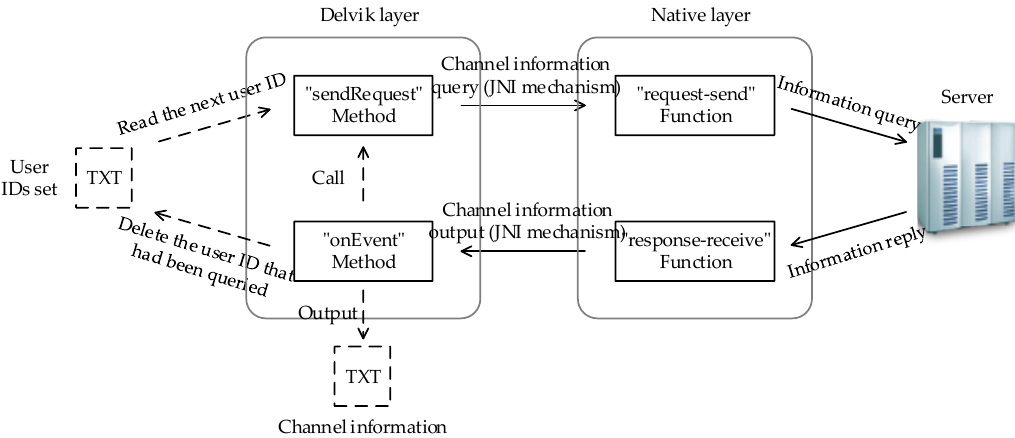
Figure 16. Model of channel information query.